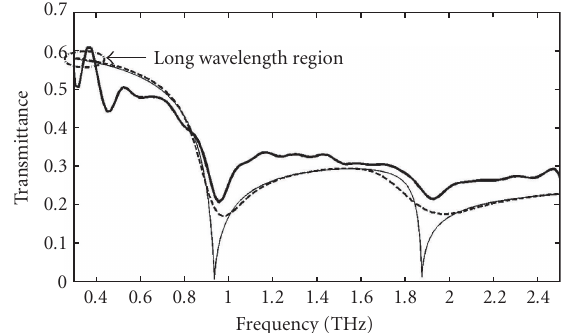
Figure 3: Comparison between experimental result and theoreti- cal calculation. The thick solid line shows the experimental trans- mittance as indicated in Figure 2(c). The thin solid line denotes the theoretical transmittance of the grating with uniform period p = 320 μ m. The dashed line is a theoretical simulation assuming the grating period fulfills normal distribution with mean 320 μ m and standard deviation 20 μ m. The circle marks the transmittance in the long-wavelength